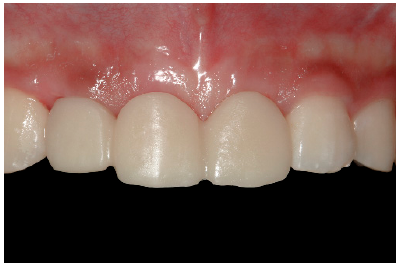
Figure 5. Placement of the other set of provisional restorations at 2 months postoperation.